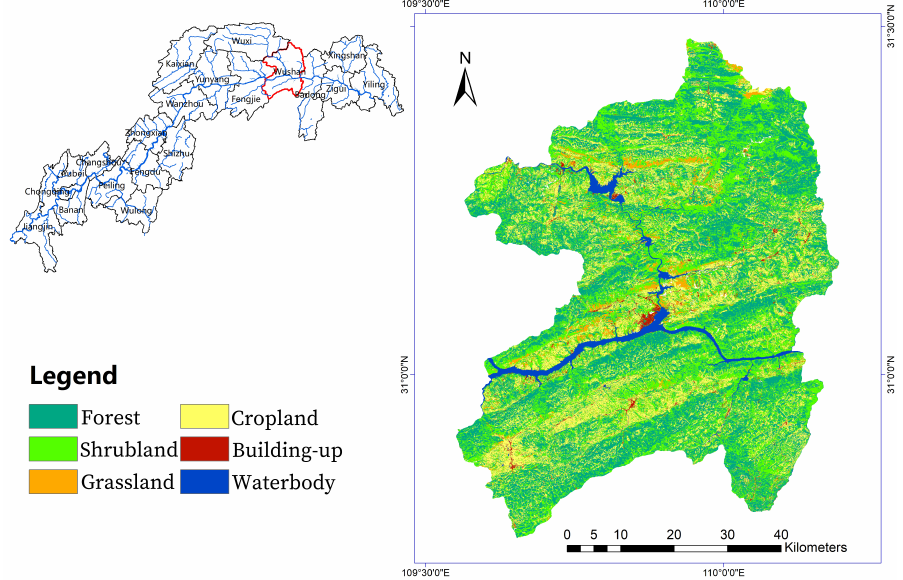
Figure 2. Wushan county with its LULC map in 2012. This LULC map was used for model training and